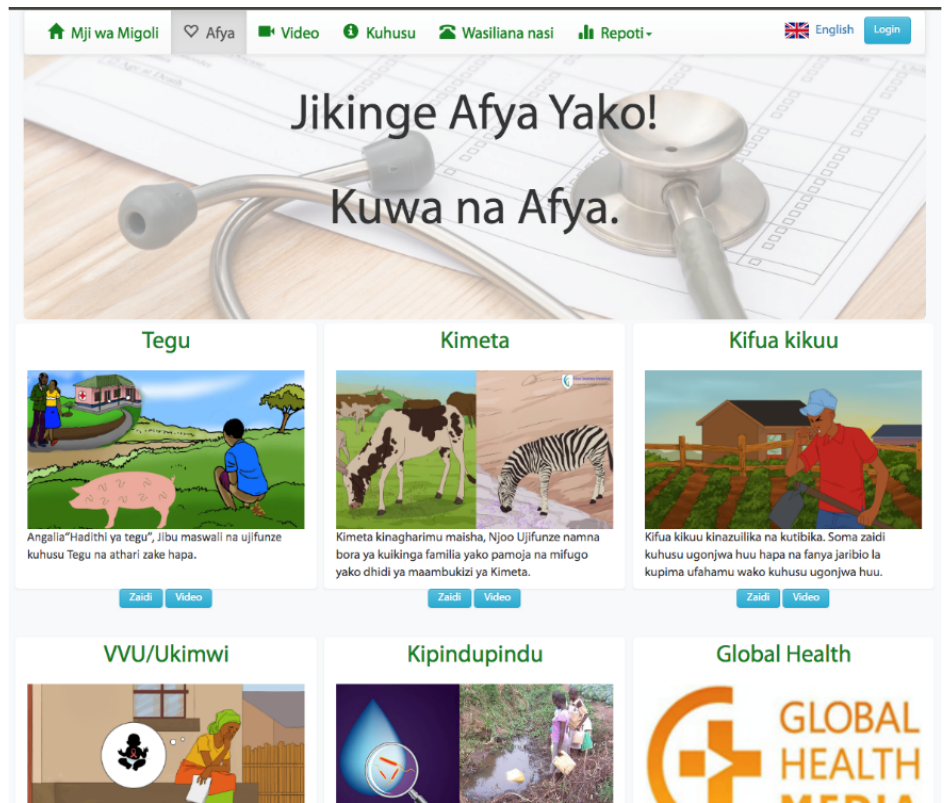
Figure 1. Screenshot from the web prototype developed in the DigI